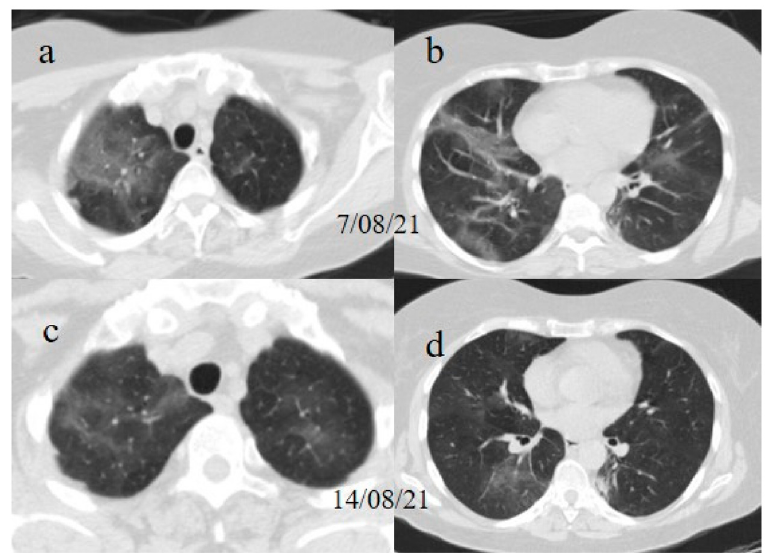
Figure 7. Chest CT performed on 7 August ( a ) showing some new GGO in the superior lobes and also in the middle and inferior lobes ( b ). On the chest CT performed a week later was visible the resolution of some GGO ( c , d ).